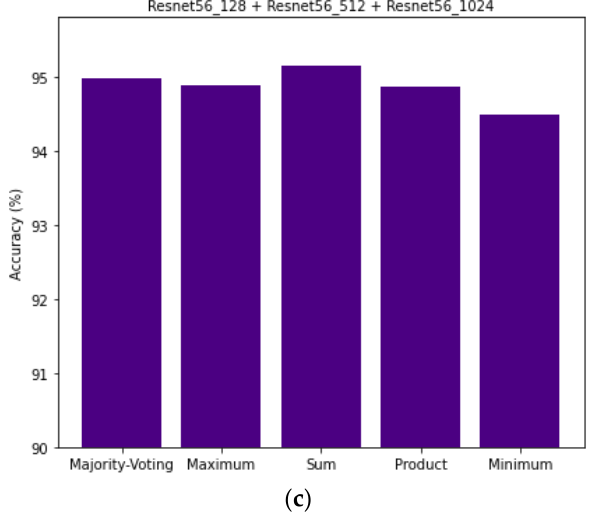
Figure 7. ( a – c ): Accuracy using different fusion strategies in case of fusion of similar models with different batch-sizes.